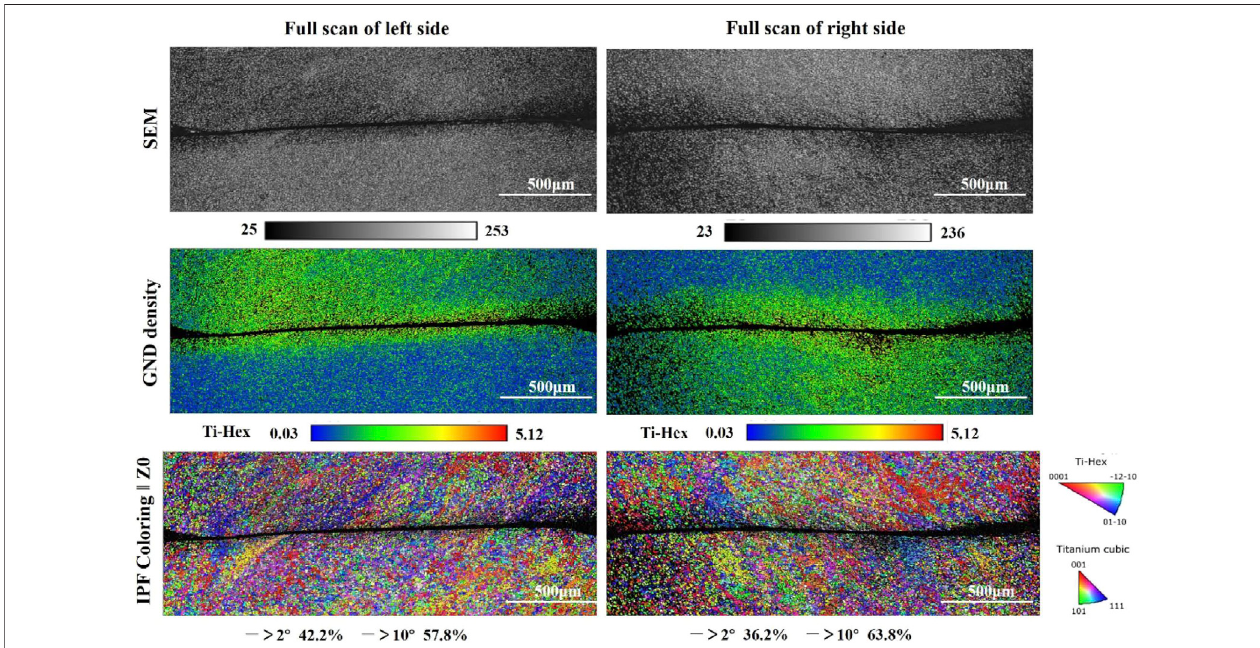
FIGURE 9 | The features of the hat-shaped sample in terms of back scattering (BC), geometrically necessary dislocation (GND) map, and the coupling analysis of inverse pole fi gure and grain boundary map (IPF + GB) at strain rate of 2.3 × 10 4 s − 1 .